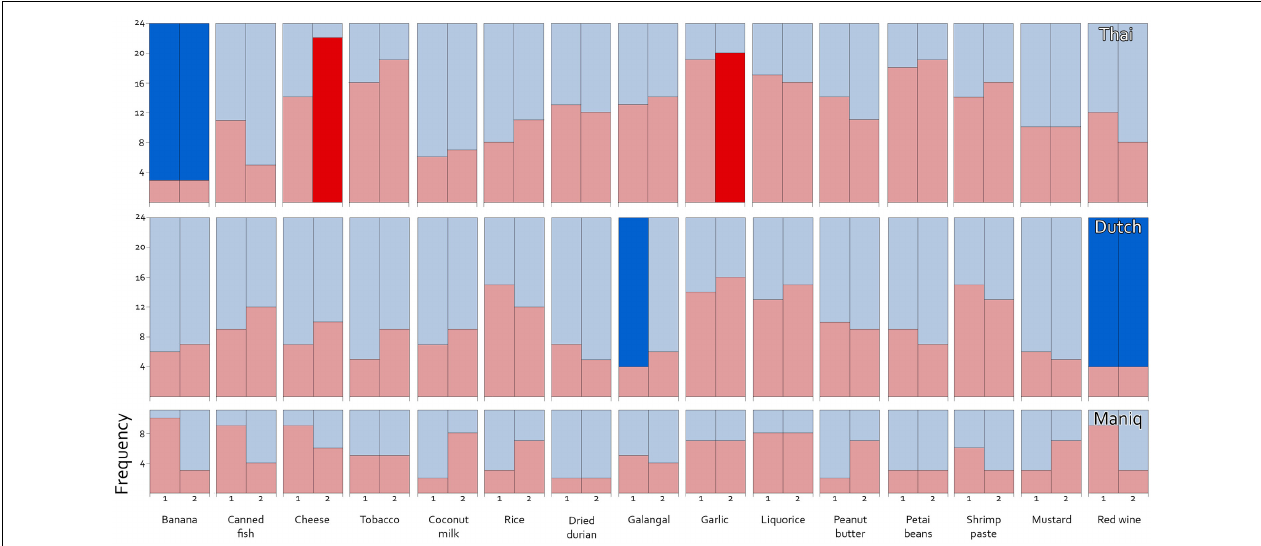
FIGURE 1 | Temperature choices for odor, session, and language. Y -axis represents the frequency of hot (red) or cold (blue) choices. Binomial tests were conducted to test whether odors were significantly related to hot or cold temperature. Significant odor temperature associations are depicted by saturated colors. All other cases failed to reach